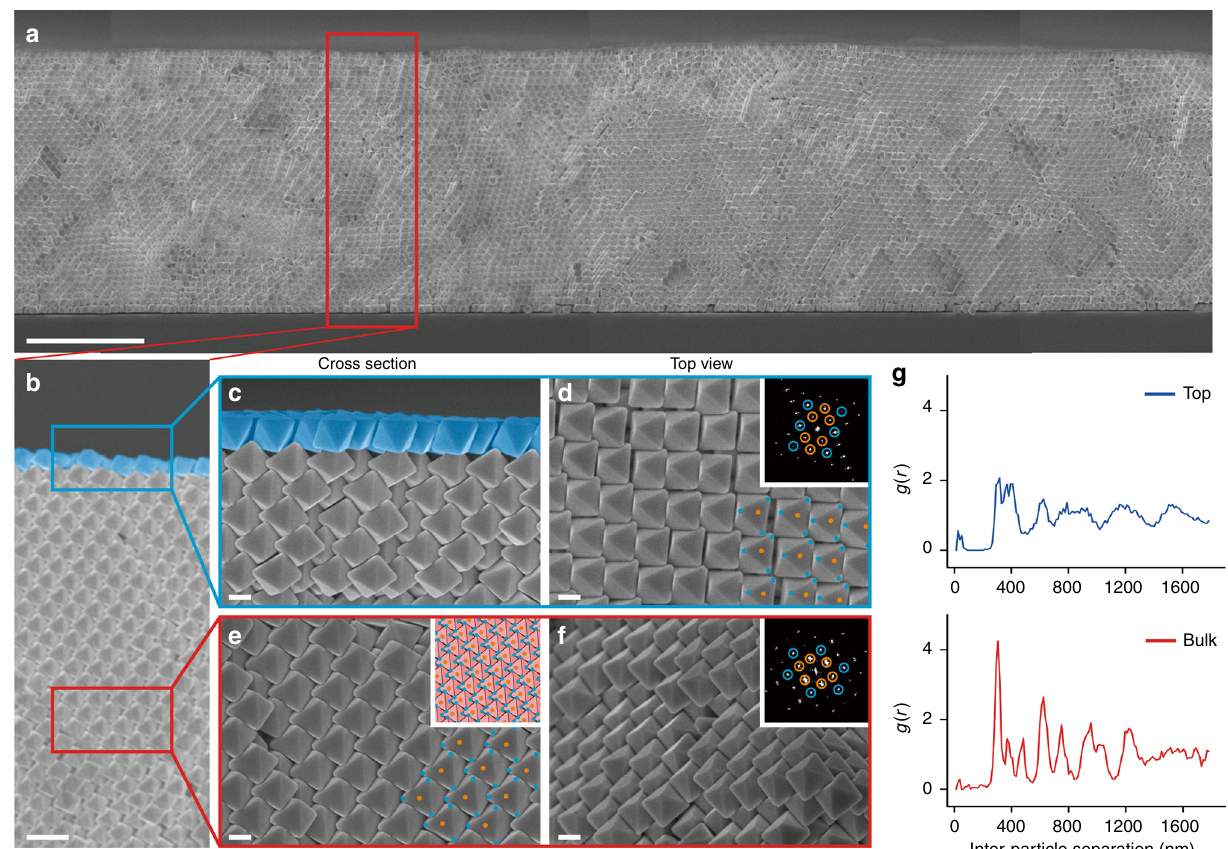
Fig. 2 Dual crystal structure formed using Ag octahedra in water. a , b Cross-sectional panoramic characterization shows the formation of large-area supercrystals with long-range order. The heights of the supercrystal are nearly uniform at ~10 µ m and stretching more than 50 µ m across. c – f The supercrystal can be divided into two distinct regions. c , d The top layer features an open structure with Ag octahedra possessing long-range orientational order and reduced translational order relative to the bulk. e , f The bulk of the supercrystal is crystalline, and can be indexed to the Minkowski lattice (inset of e ). a Scale bar, 5 µ m; b scale bar, 1 µ m; c – f scale bars, 200 nm. Insets of d , f are the FFT images of the respective crystal structure. The Ag octahedra in the open structure resembling a liquid crystalline phase are color-coded for ease of discussion. g Radial distribution functions of the respective